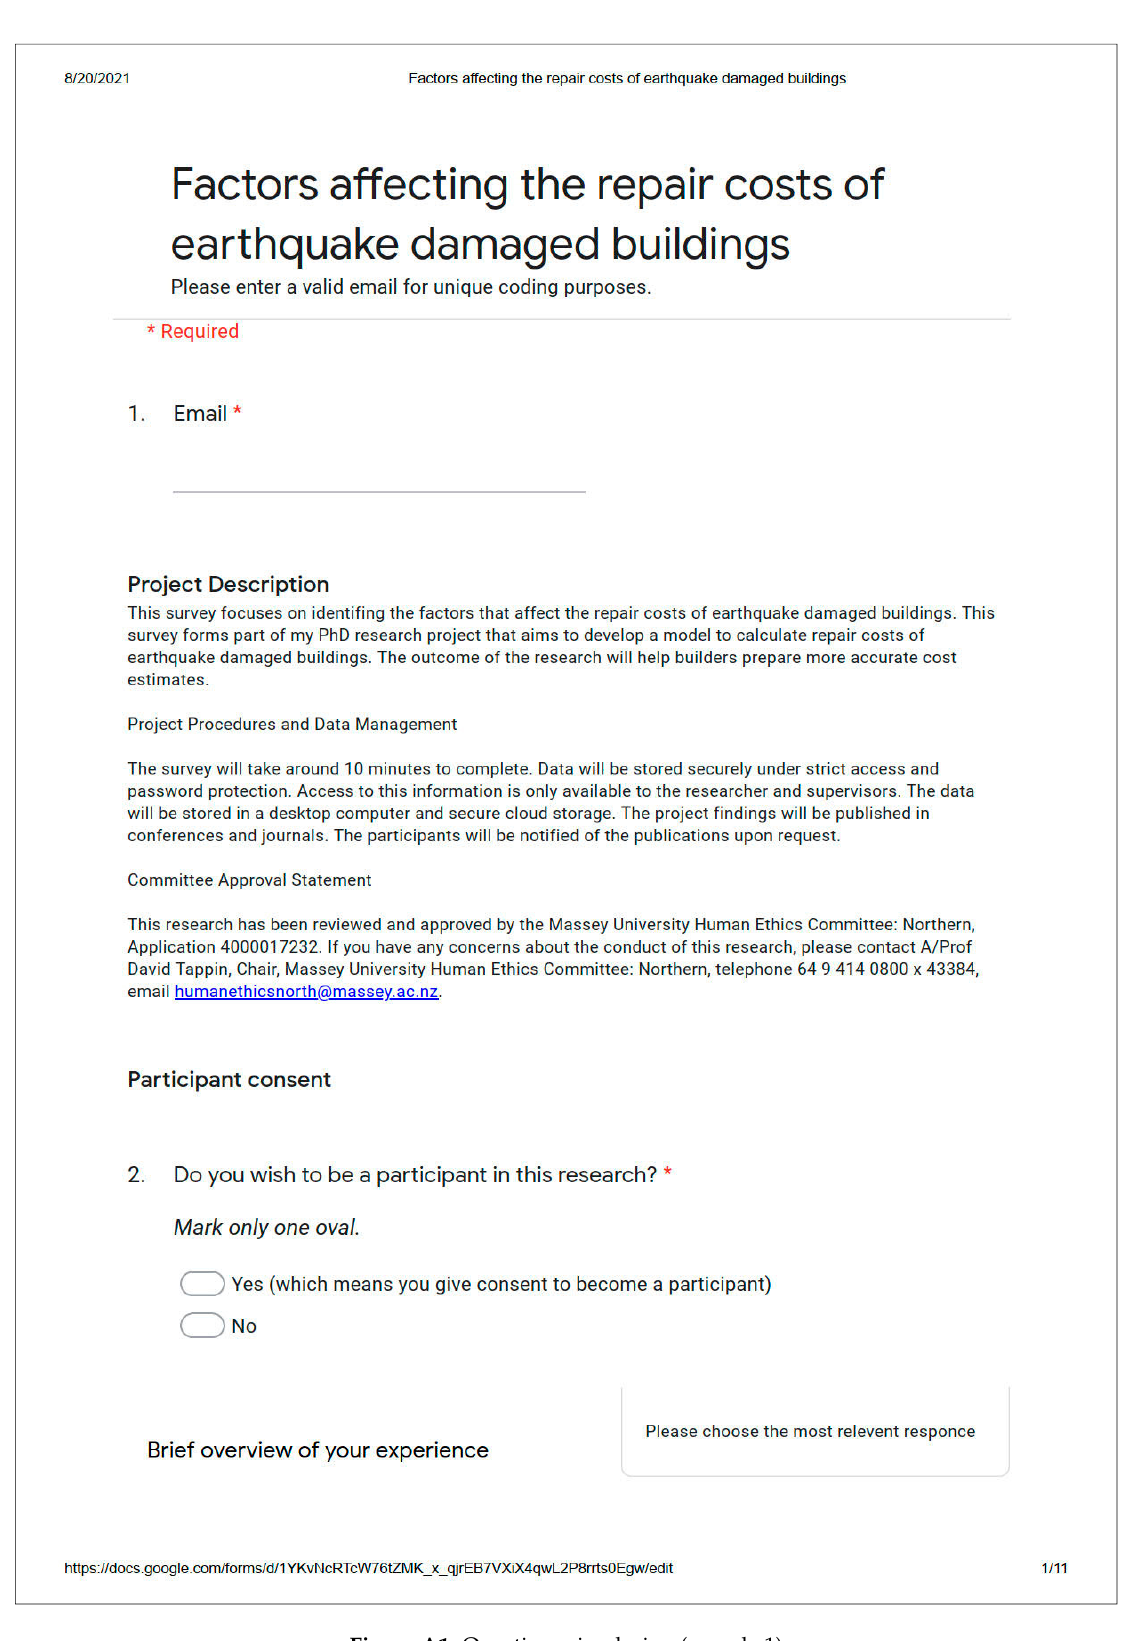
Figure A1. Questionnaire design (sample 1).